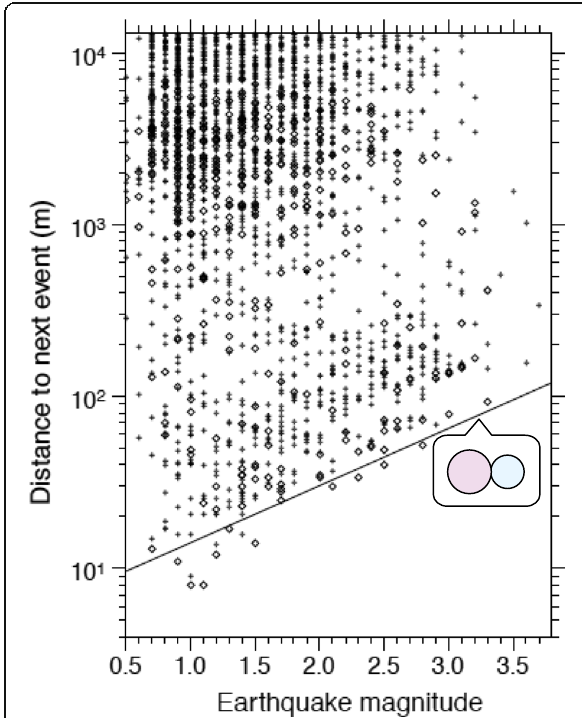
Fig. 6 Relationship between the magnitude of the first event and distance to the second earthquake for consecutive earthquakes in the creeping section of the San Andreas fault (after Rubin et al. 1999). Diamonds indicate that the vertical separation between the events exceeds the horizontal separation; crosses indicate the reverse. The diagonal line is the estimate of earthquake radius derived from the moment-magnitude relation of Abercrombie (1996), assuming a stress drop of 10 MPa